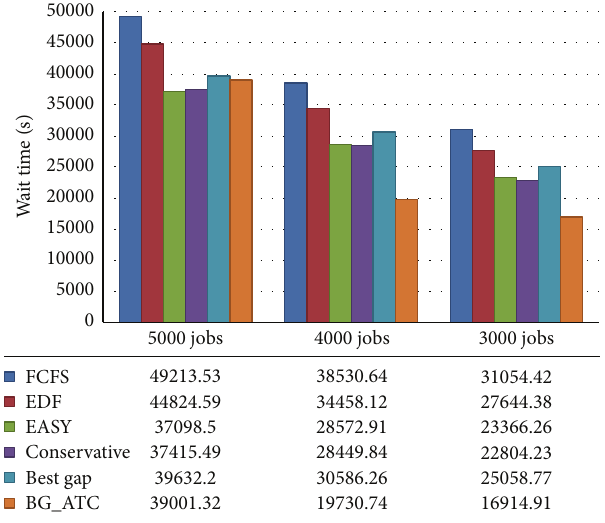
Figure 9: Wait time examination on blue